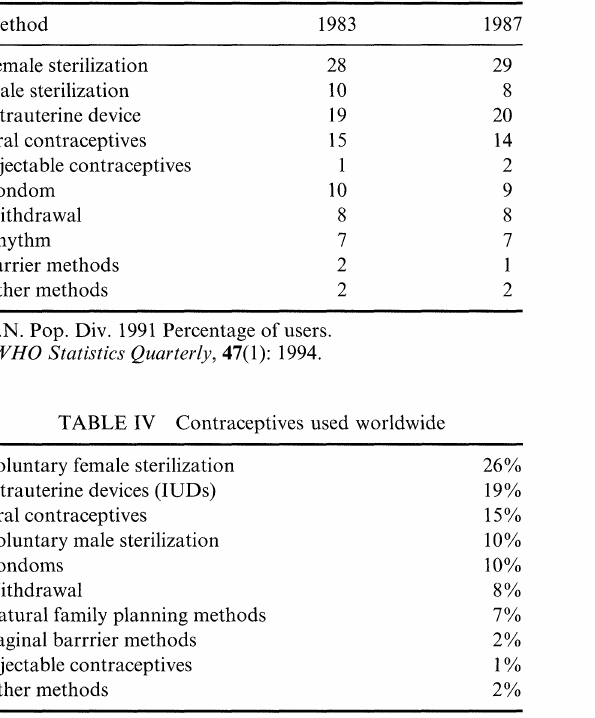
FIGURE 2 Percent of married couples (wives 15-44) using sterilization, pill, condom U.S. 1973 1988. (Reprinted with permission from Mosher and